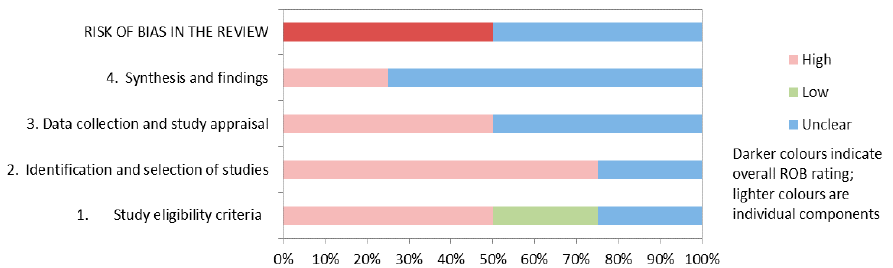
Figure 2. Risk of bias assessment of the identified reviews. Based on Whiting et al., 2016 [17], ROB = risk of bias. The table shows the risk of bias in the included references.